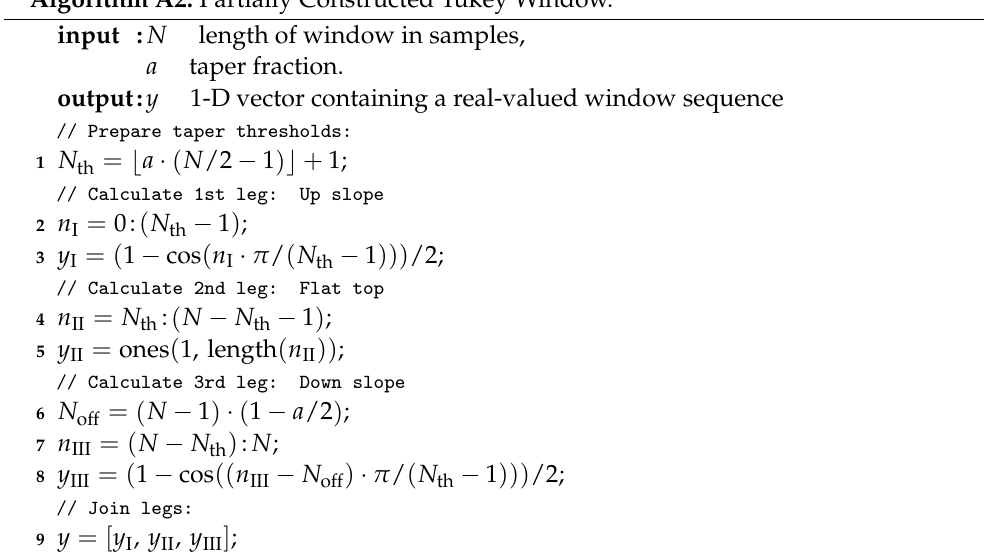
Algorithm A2: Partially Constructed Tukey